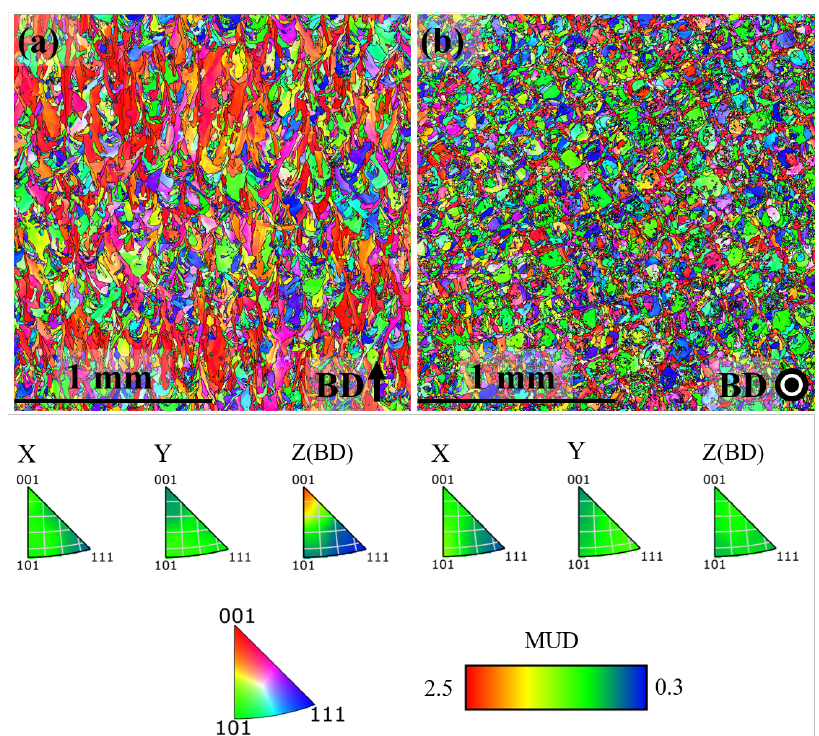
Figure 4. IPF map in the AB condition ( a ) x-z plane ( b ) x-y plane.